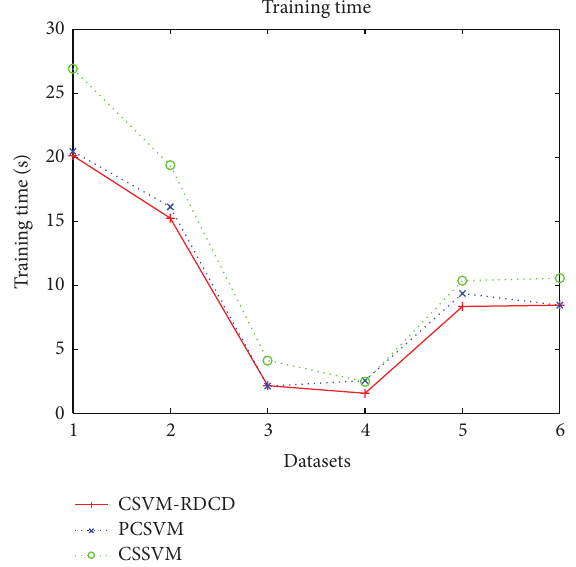
Figure 3: Training time (s) comparison of three algorithms using CSSVM. Table 3: Specification of the benchmark datasets and cost-sensitive parameters on the dataset. Dataset Fault diagnosis of wind turbine Number of ex. 20000 Number of feat.